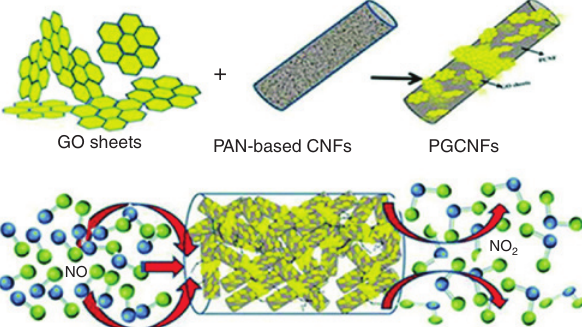
Figure 6: Schematic diagram of reduced graphene oxide (rGO) embedded in CNFs forming of graphene/PAN-based carbon nanofib- ers (PGCNFs) and the process of oxidation of NO to NO see Ref. [36]; reprinted with permission from Royal Society of